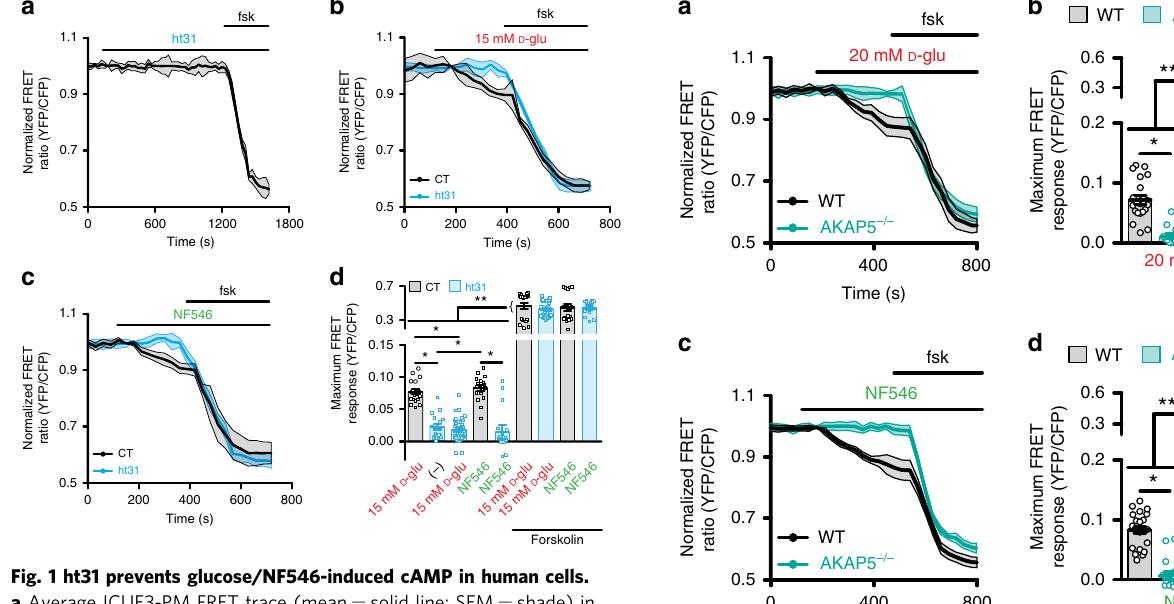
(Supplementary Fig. 3) or an inability of AKAP5 − / − arterial myocytes to produce cAMP as forskolin response remained intact in these cells (Fig. 2). These results suggest a role for AKAP5 in spatially con fi ning cAMP synthesis in response to elevated glucose and activation of the P2Y 11 -like receptor in mouse arterial myocytes.